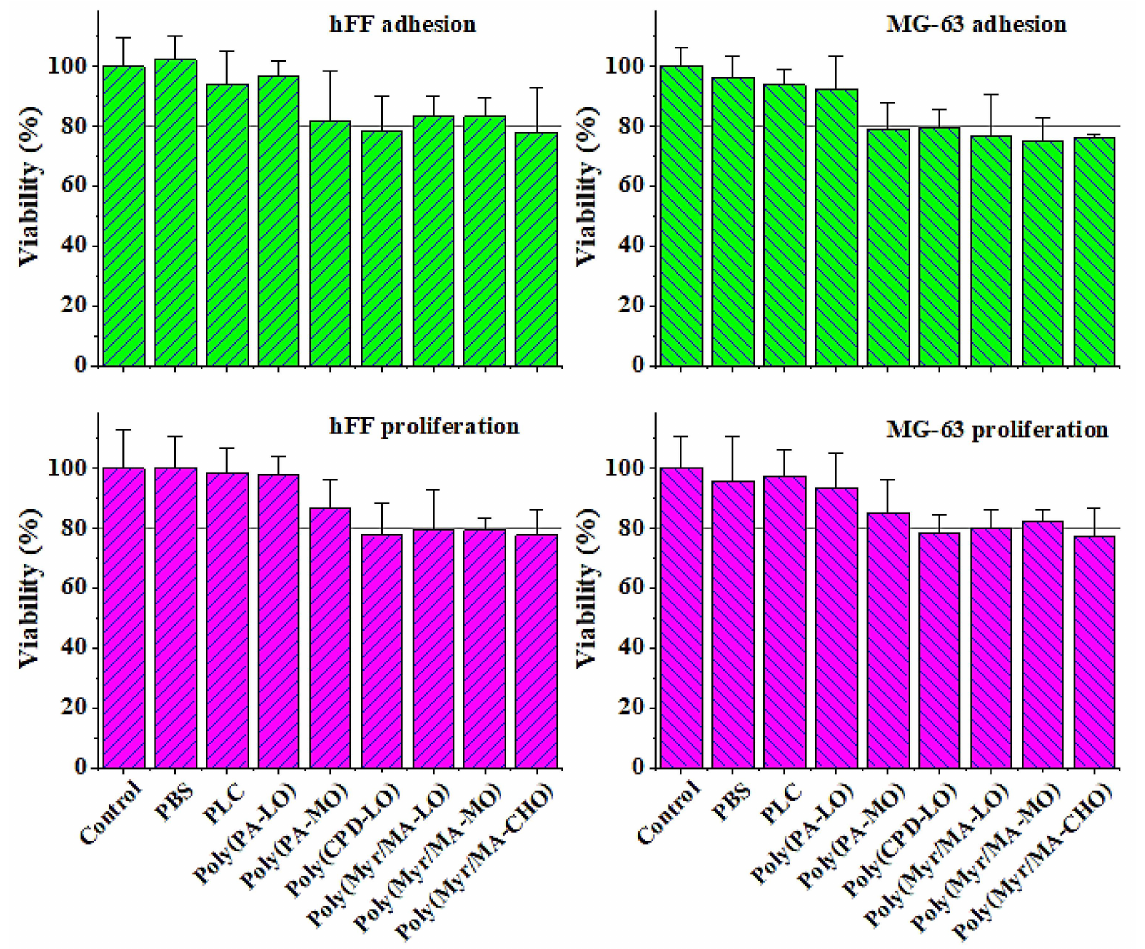
Figure 10. Cell adhesion and proliferation onto the surface of terpenoid-derived polymeric tablets. An MTT assay was performed at 24 h (adhesion test) and 96 h (proliferation test) of